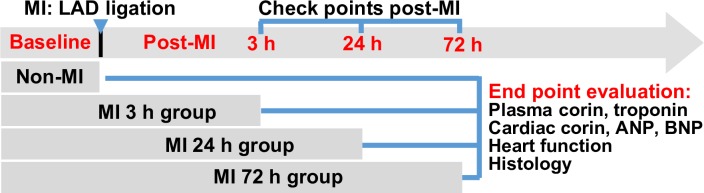
A schematic diagram showing the detailed animal groups involved in this study.Experimental mice were randomly assigned into four groups, including Non-MI, MI-3 h, MI-24 h and MI-72 h. Non-surgical mice served as non-MI control [17] and were euthanized after echocardiography. Mice in MI groups were euthanized at 3 h, 24 h and 72 h post-MI respectively after echocardiography. Blood samples and organs were collected from all experimental animals to measure plasma corin, troponin, cardiac corin, ANP and BNP, and to do histologic examination.